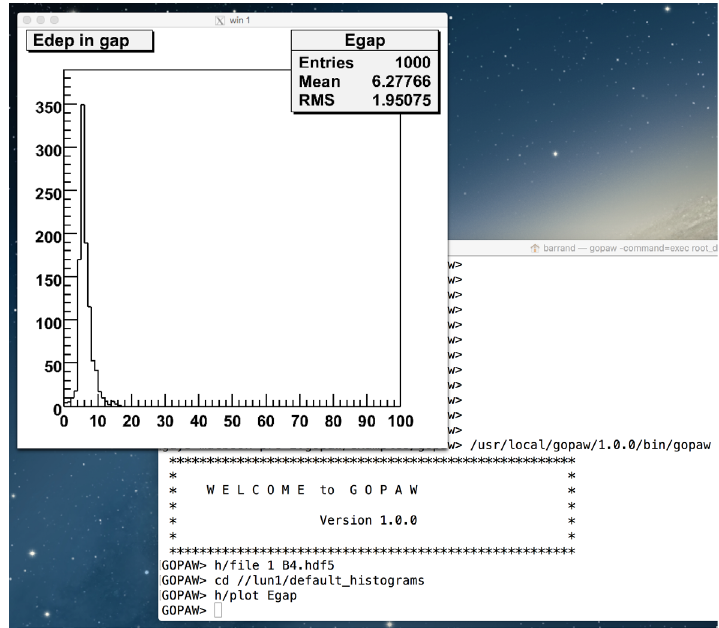
Figure 1. gopaw on the B4 hdf5